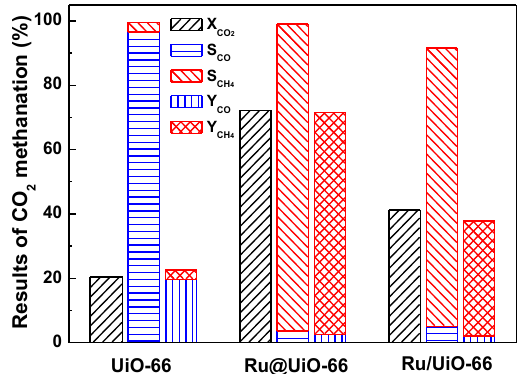
Figure 9. Dielectric barrier discharge (DBD) plasma-assisted CO 2 conversion over UiO-66, Ru@UiO-66, and Ru / UiO-66, Reproduced from [38], Copyright Hefei Institutes of Physical Science, Chinese Academy of Sciences and IOP Publishing,